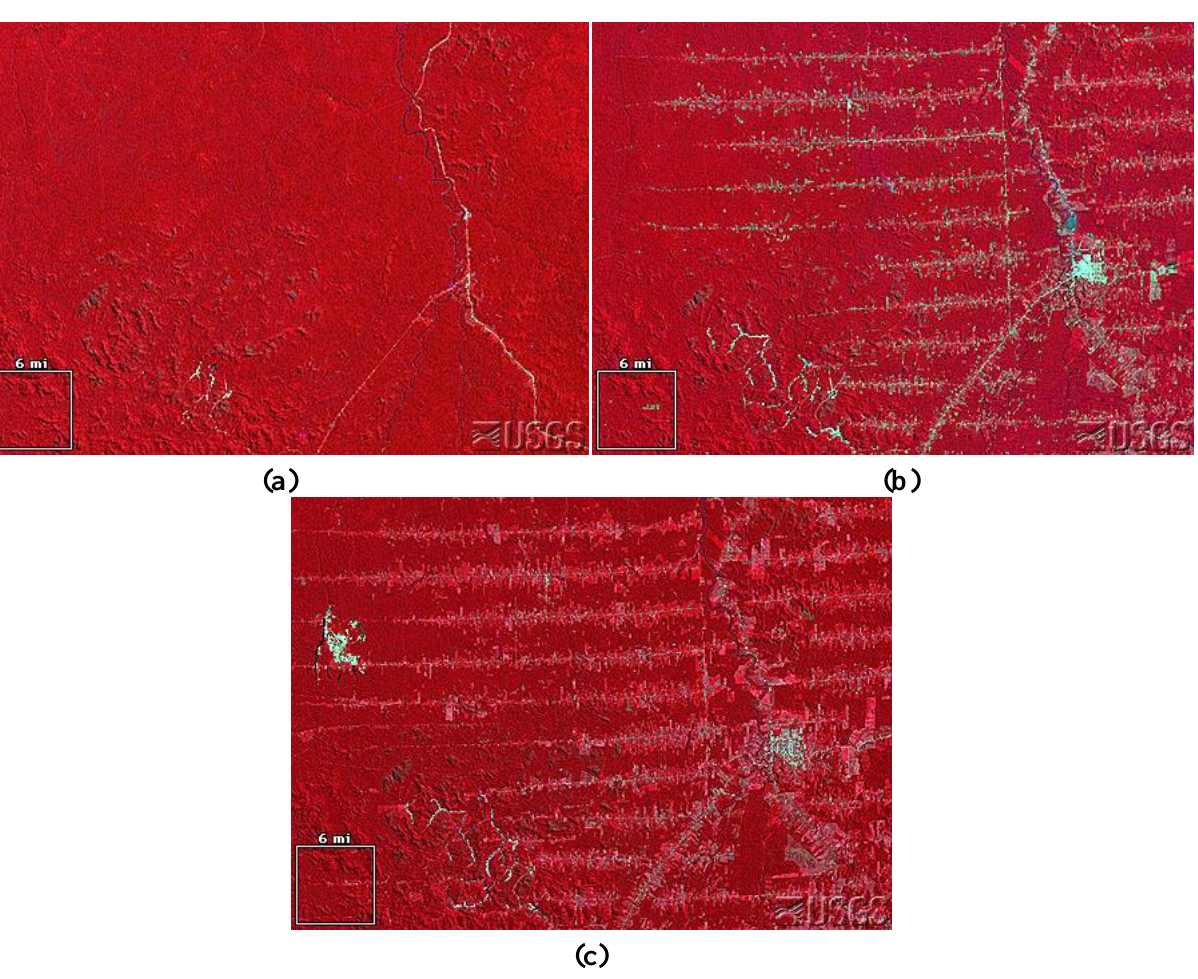
Figure 1. “Fishbone” pattern of deforestation off of a main road in Amazon forest in Rondônia, Brazil (a) in 1975 prior to main road construction (Landsat 2 MSS), (b) in 1986 just after the main road was built (Landsat 5 MSS), and (c) in 1992 (Landsat 4 TM) [72]. Red color indicates vegetation, light blue is bare ground. Images from US Geological Survey